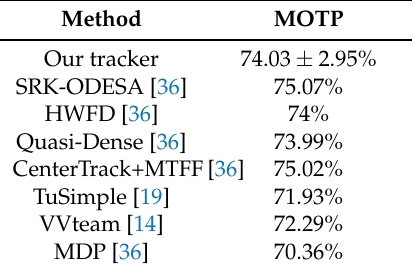
Table 3. Multiple Target tracking evaluation metrics for KITTI Pedestrian tracking